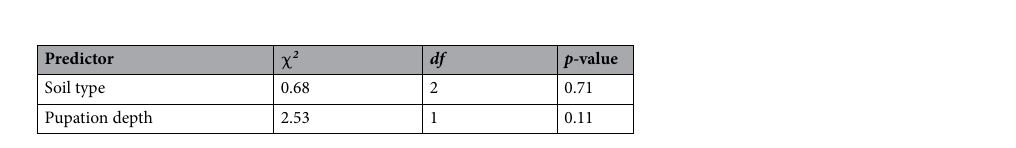
Table 3. Hatched wasps—generalised linear mixed effect model (family = binomial, link = logit, random factors: “Box/pupae number”, “Percent Pupated”) examining the effects of pupation depth and soil type on the hatching rate of the wasp T. drosophilae on D. suzukii pupae.